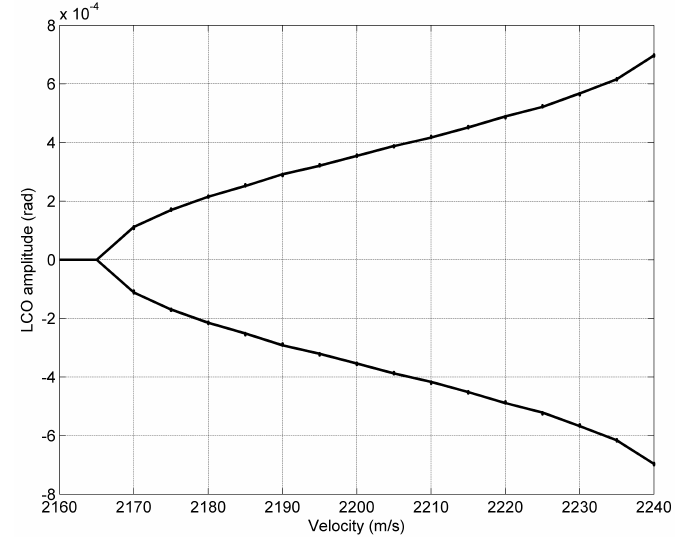
Figure 7. Bifurcation plot for cold